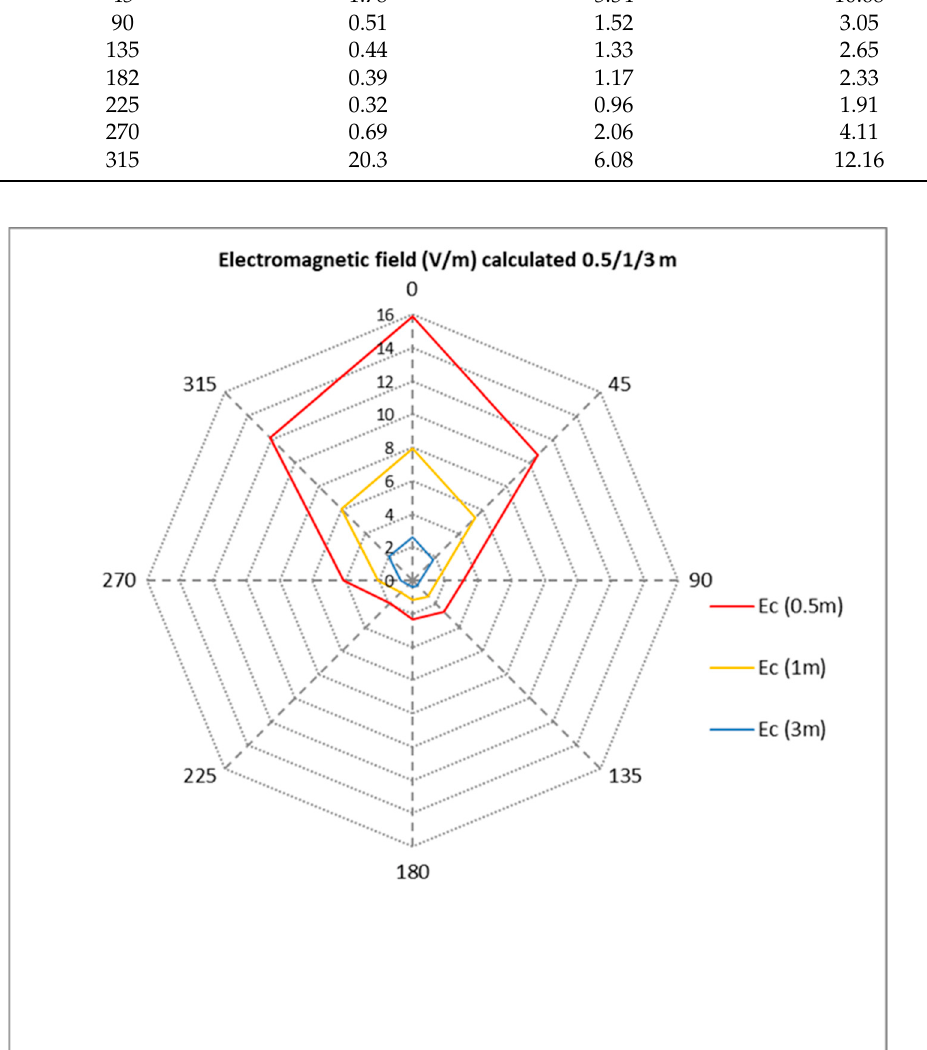
Figure 9. Spatial distribution of E-field calculated near AG-RFID reader